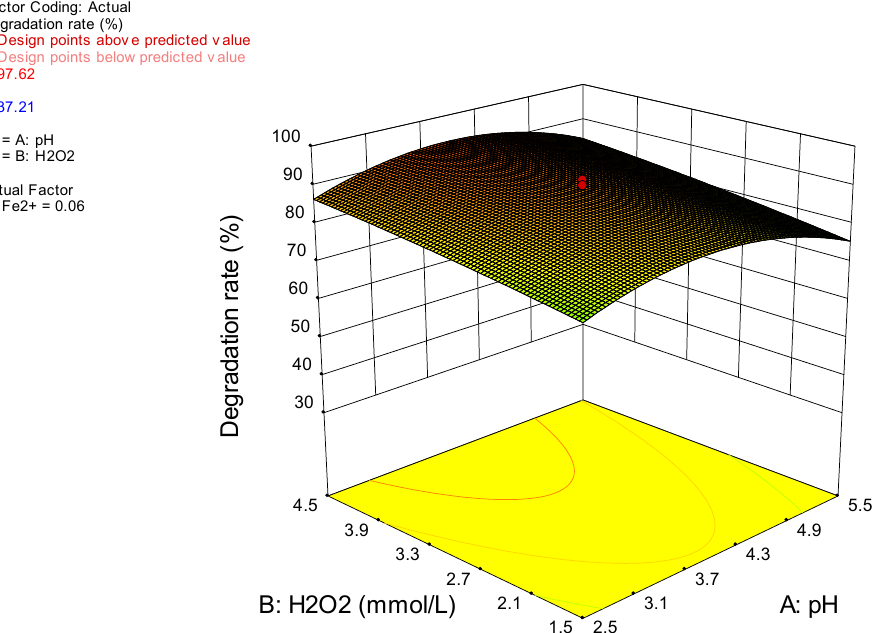
Figure 8. The influence of pH and H 2 O 2 concentration on trimethoprim degradation.